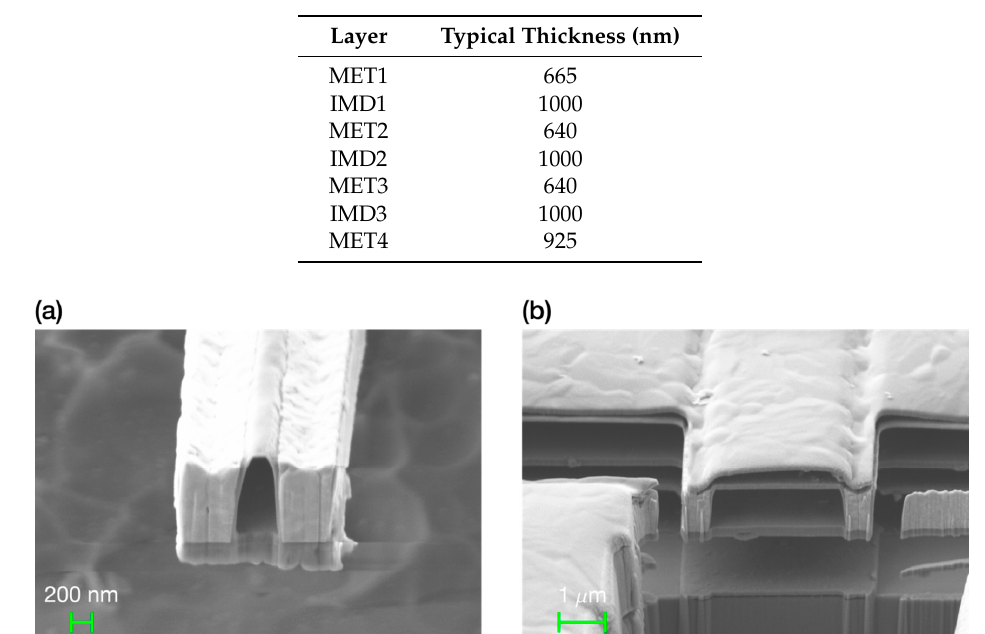
Table 1. Thickness of the different metal and interlevel oxide layers of the AMS 0.35 µ m CMOS technology.